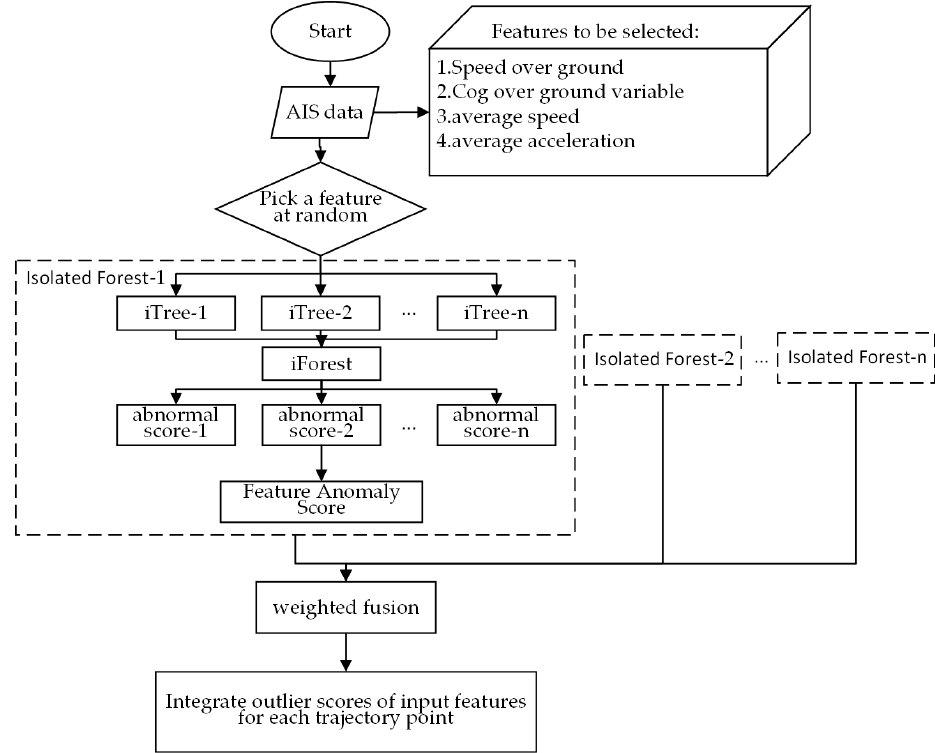
Figure 6. Flowchart of detection of abnormal ship behavior with thematic attributes based on isolated forest.